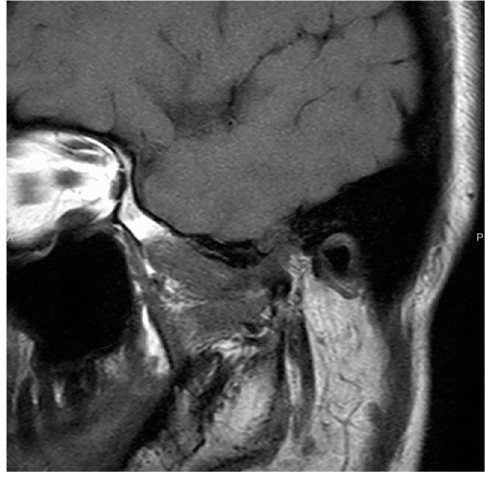
Figure 9. Imaging results in patient 2 after surgery. Magnetic resonance imaging. Six years after surgery, there is no recurrence.